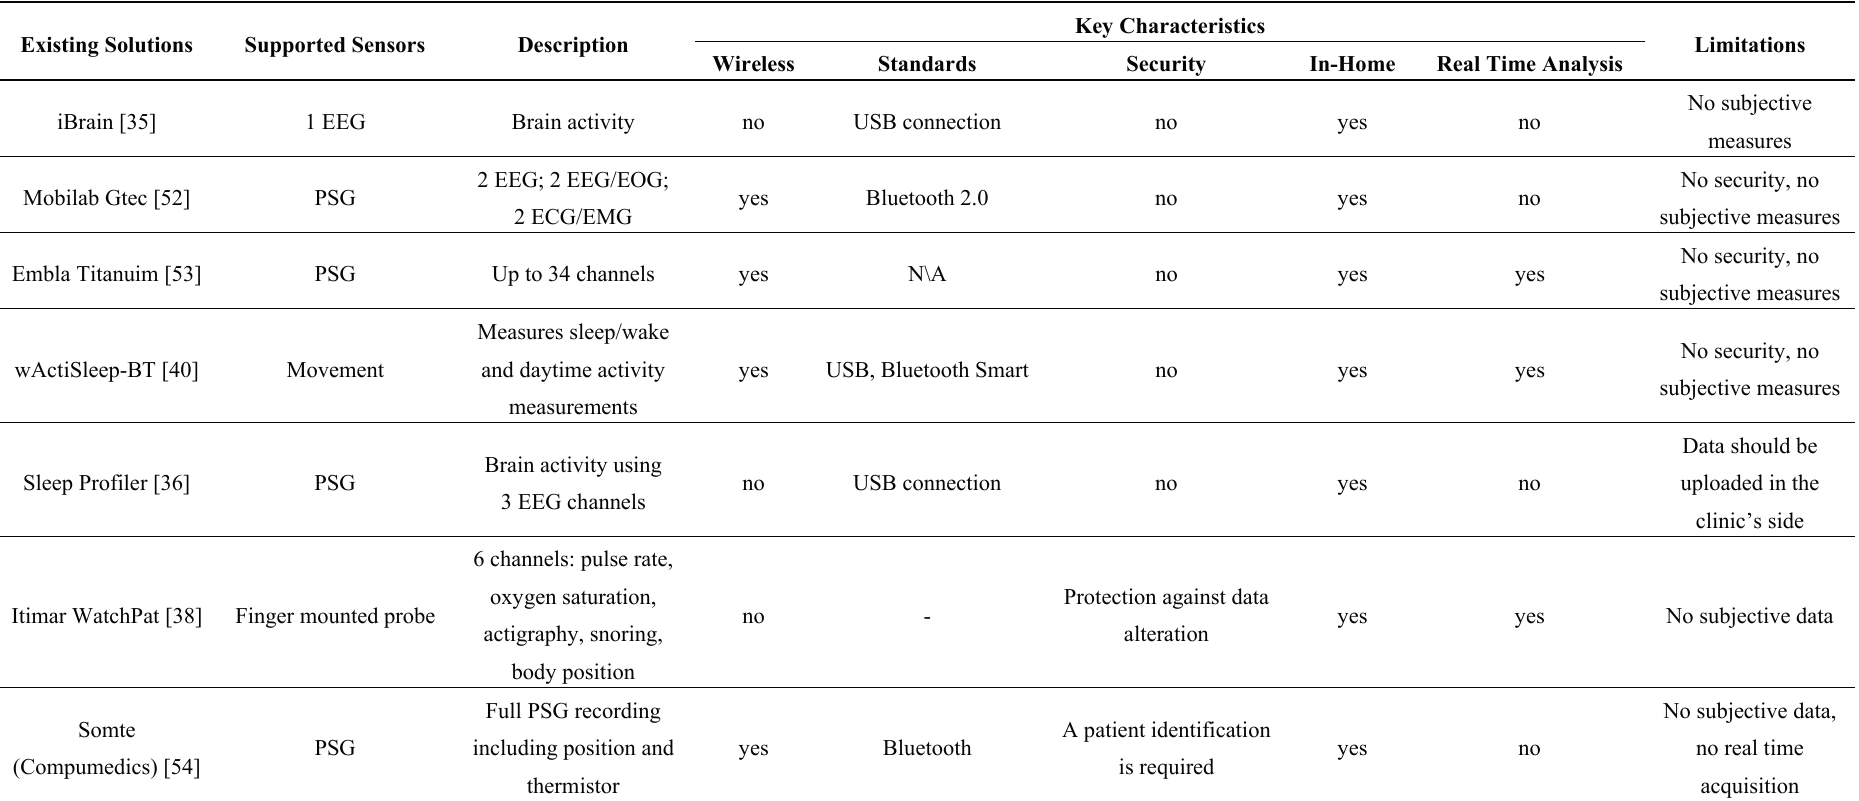
Table 4. Existing sleep monitoring